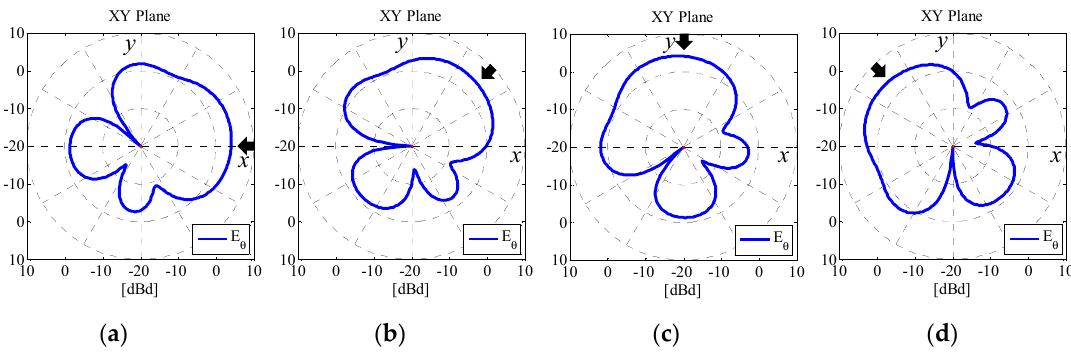
Figure 10. Radiation pattern of Subarray2 when the 4 × 4 MIMO antenna is used. ( a ) ϕ = 0 deg (Combination1). ( b ) ϕ = 45 deg (Combination2). ( c ) ϕ = 90 deg (Combination3). ( d ) ϕ = 135 deg (Combination4).